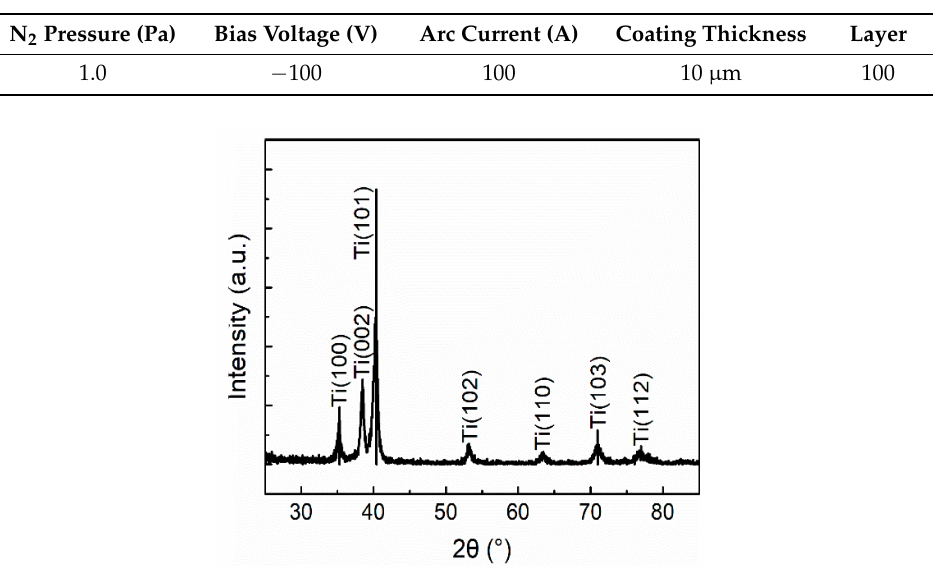
Table 2. Processing Parameters.